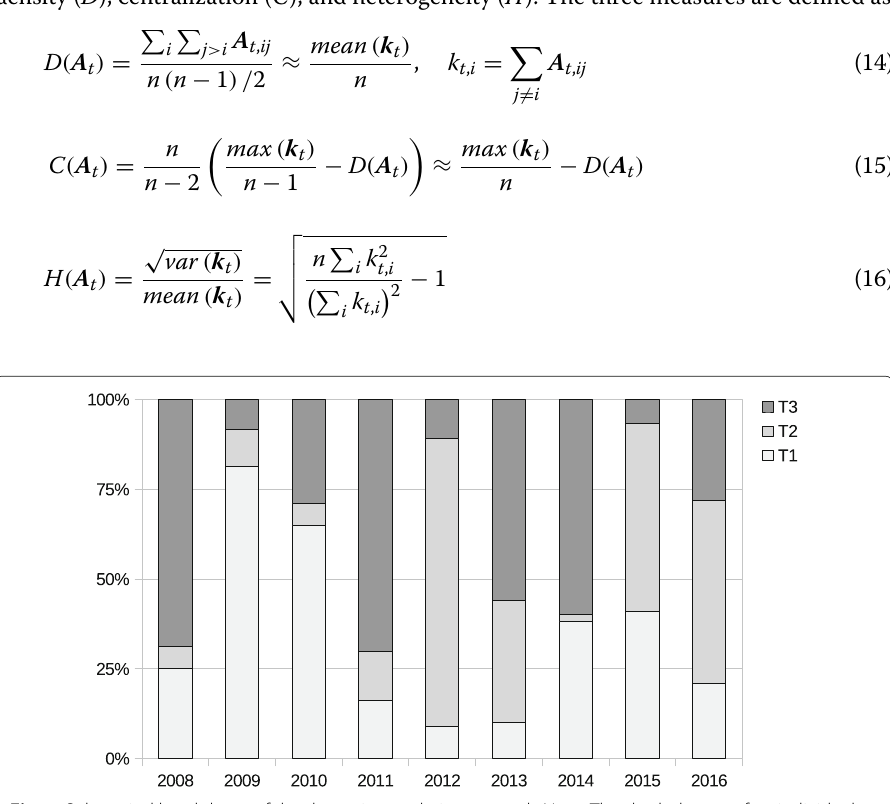
Fig. 7 Sub-period breakdown of the dynamic correlation network. Note: The shaded areas of an individual bar represent the shares of three sub-period categories, T1 , T2, and T3, in each year. The share is calculated as the ratio of number of trading days of each category to the total trading days in the